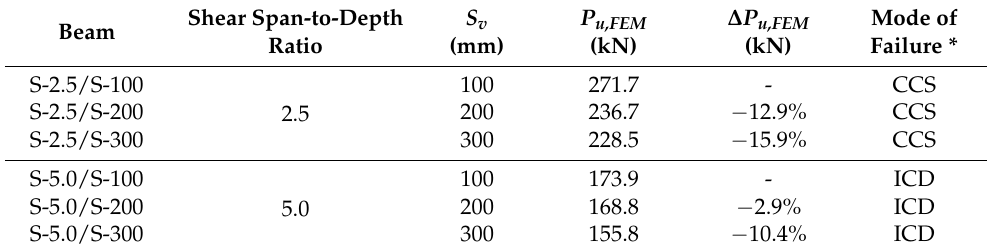
Table 7. Ultimate capacities and failure modes obtained by FE analysis on the effect of stirrup spacing. Shear Beam